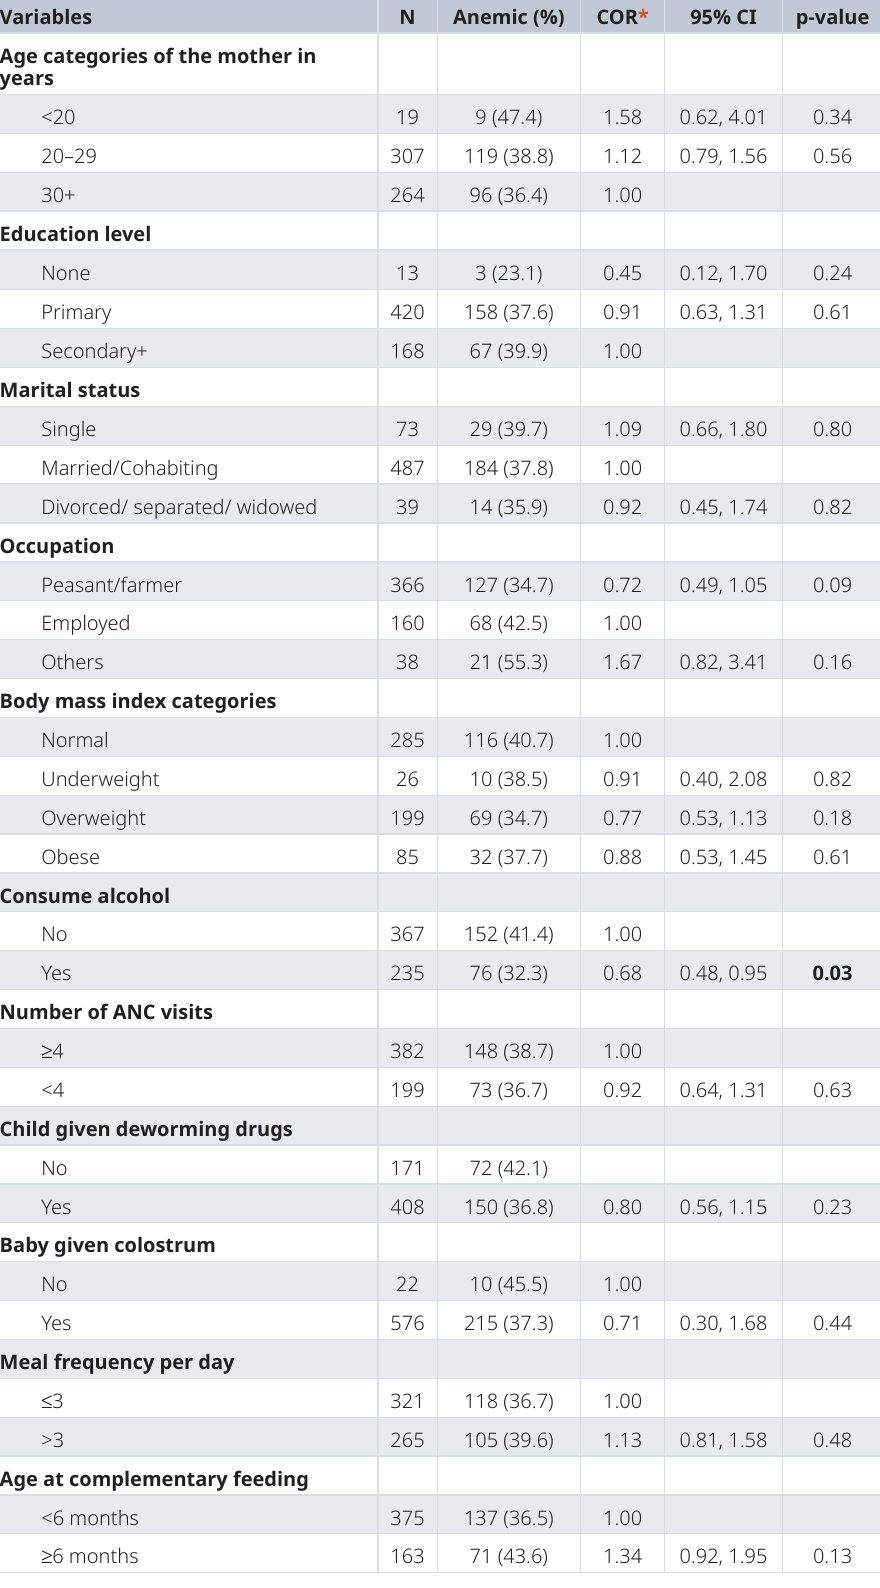
Table 3. Crude analysis for factors associated with anemia in children under five (N=602). Variables N Anemic (%) COR* 95% CI p-value Age categories of the mother in years